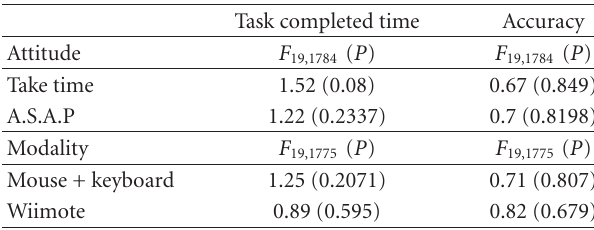
Table 6: ANOVA test across depth profiles.